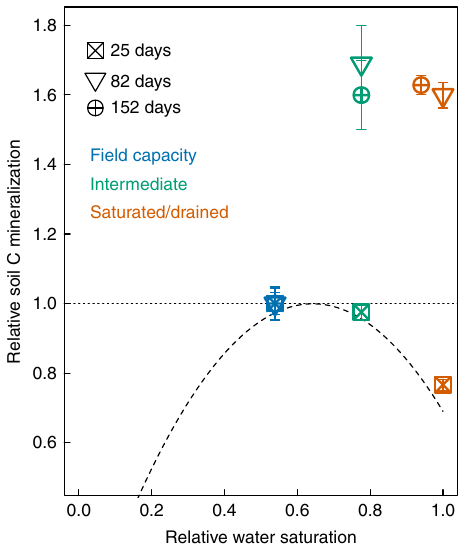
Fig. 2 Relationships between soil moisture and cumulative C mineralization. Values of soil C mineralization from our study were normalized by the values at fi eld capacity measured at 25, 82, and 152 days, respectively. Soil moisture for the saturated/drained period at 152 days is the mean value over this experiment. The dashed line is the best- fi t relationship from Moyano et al. 5 : SR H = 3.11 θ S − 2.42 θ S 2 , in which SR H is soil C mineralization and θ S is relative water saturation. Each point is the averaged value across the three Mollisols. The error bars indicate s.e.m. ( n =